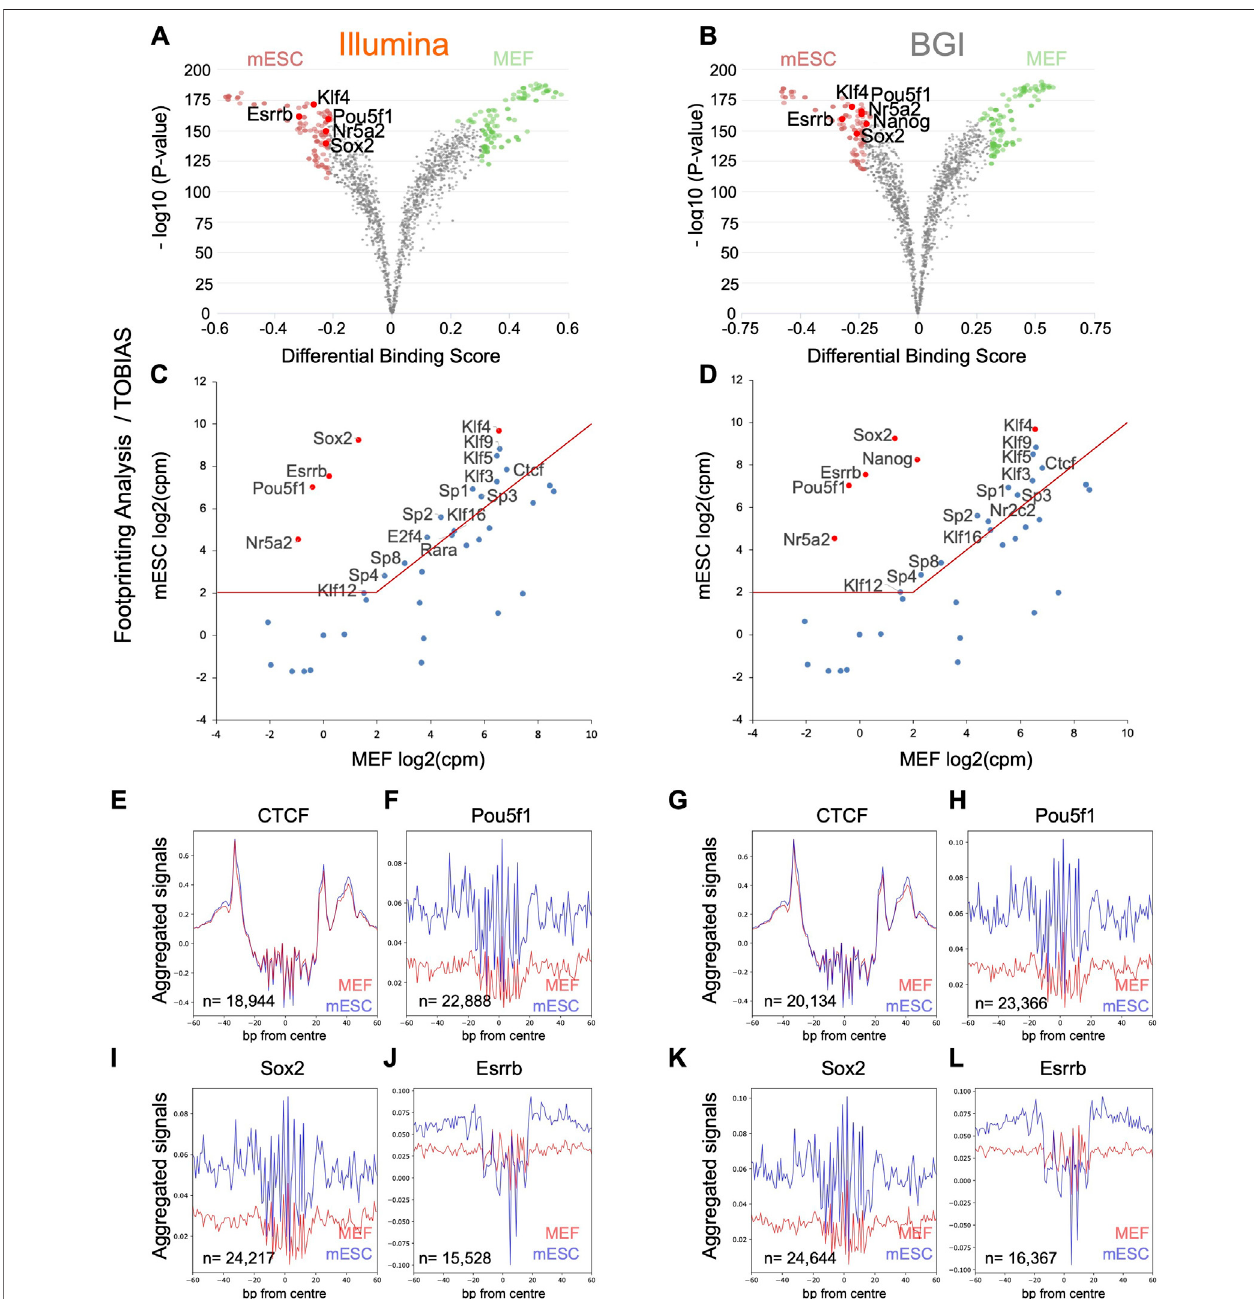
FIGURE 5 | Foot-printing analysis with TOBIAS pipeline to recover TF that underpins the mESC identity. (A,B) TF binding changes quanti fi ed by TOBIAS pipeline arevisualizedintheformofvolcanoplots(analysisisbasedonthemergeddataofthreebiologicalreplicatesasTOBIASdoesnotacceptreplicatedata). (C,D) Thetop40 motifs identi fi ed by TOBIAS with higher binding activity in mESC were integrated with transcriptional data for mESCs and MEFs ( n = 3 biological replicates) to visualize expression differences of these TFs across both cell types. The top fi ve to six motifs (re-ranked by expression differences) are indicated in red containing three published 3-factor combinations previously demonstrated to enable pluripotency induction (Pou5f1, Sox2, Klf4; Pou5f1, Esrrb, Klf4; Nr5a2, Sox2, and Klf4). (E – L) Representative aggregate accessibility pro fi les of TFBS with evidence for occupancy in one of the cell types for CTCF, Pou5f1, Sox2, and Nanog (pro fi les are based on themergeddataofthreebiologicalreplicates).ThenumberofTFBSusedtogenerateeachaggregateisindicatedinthebottomleftcornerofeachplotthatintersectwith a sample ’ s open chromatin regions.